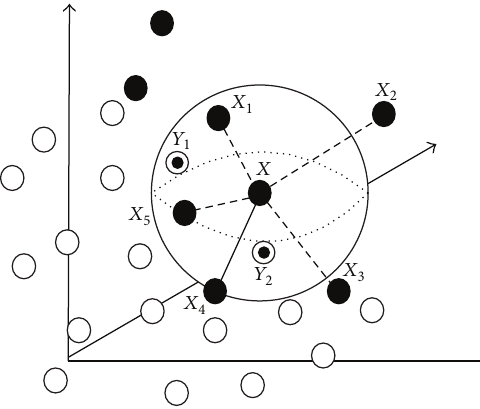
Figure 2: Schematic diagram of AIBSMOTE algorithm. minority class samples is different. So using the same